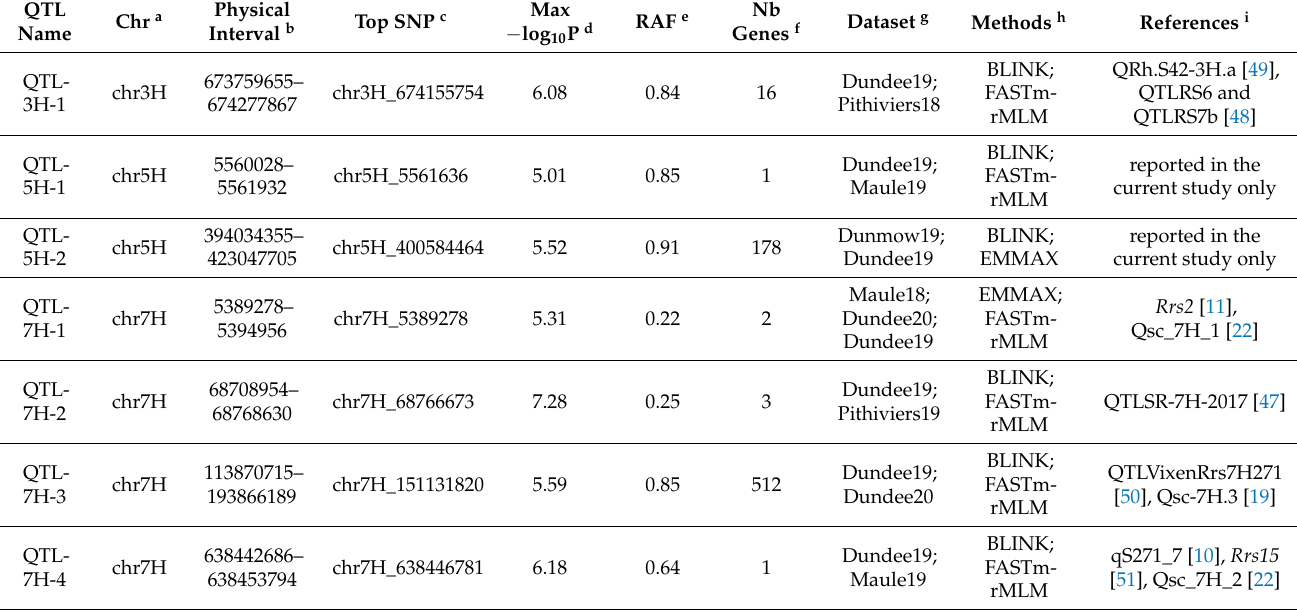
Table 3. QTL for rhynchosporium scores detected by genome-wide association study (GWAS) in at least two of the eight field trials of the